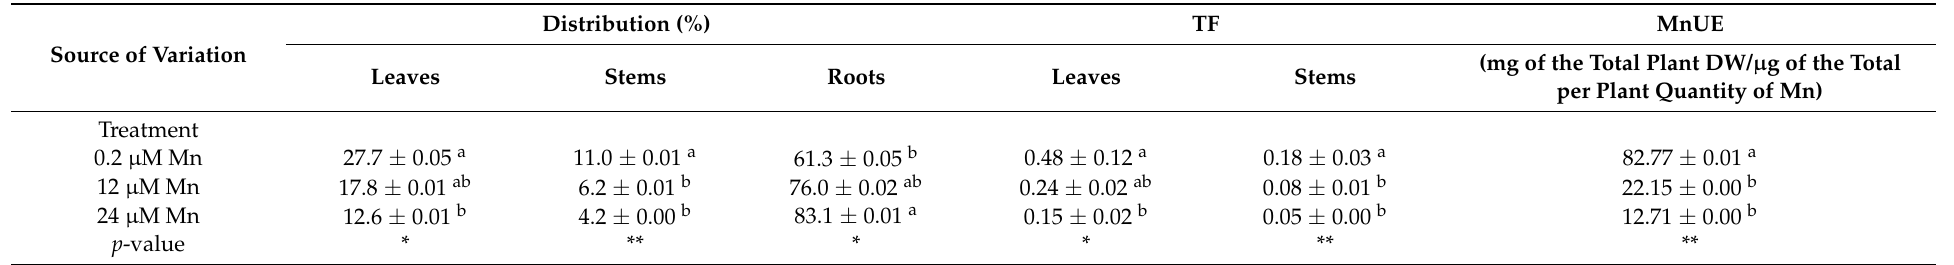
Table 3. Distribution (%) of the total per plant quantity of manganese (Mn) in leaves, stems, and roots of ‘Istarska bjelica’ olive cv., translocation factor (TF), and manganese use efficiency (MnUE)